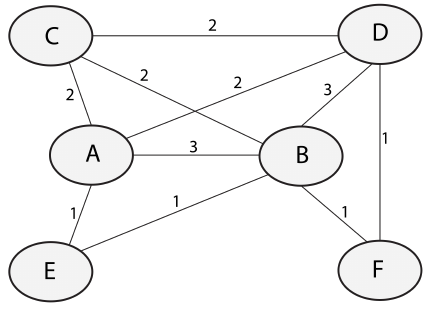
Figure 5. k -NMF anonymized